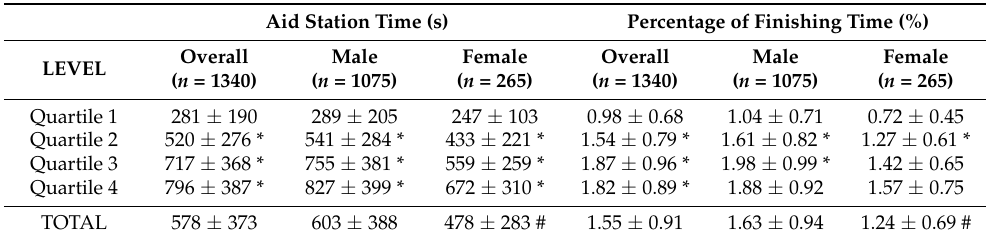
than males (F = 46.6, p < 0.001, p η 2 = 0.034), with but no level × sex interaction observed (time: F = 2.4, p = 0.066, p η 2 = 0.005; finishing time percentage: F = 1.1, p = 0.358, p η 2 = 0.002). Table 3. Time spent in the aid station by the 2021 OCC ® participants (in seconds and as a percentage of finishing times).